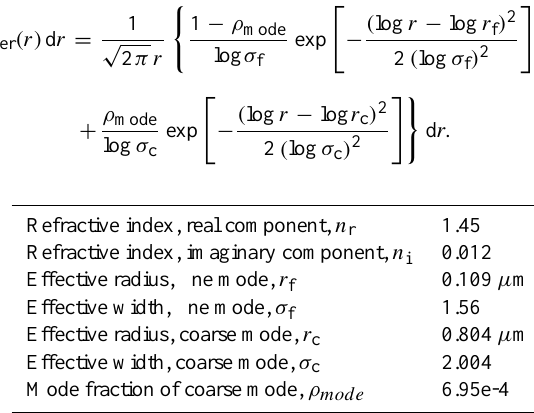
Table 1. Aerosol microphysical parameters for a coarse, urban, ab- sorbing aerosol (IA3). The bimodal number size distribution is cal- culated as p aer (r) d r